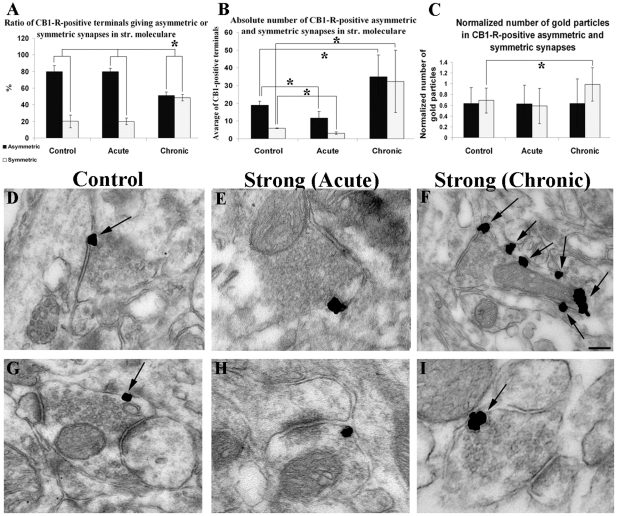
Quantitative changes of CB1-Rs in the acute and chronic phase of epilepsy.Graph A shows changes in the ratio of CB1-R immunopositive terminals establishing symmetric versus asymmetric synapses in control and epileptic tissue in str. moleculare of the DG. No difference was found in the hippocampi of strong animals in the acute phase compared to controls. However, in strong animals in the chronic phase a significant increase occurred in the ratio of stained symmetric versus asymmetric synapses. Graph B shows changes in the absolute number of symmetric versus asymmetric synapses in control and epileptic tissue. Significant decrease was found in the number of stained asymmetric and symmetric synapses in the hippocampi of strong animals in the acute phase, compared to controls. In contrast, in strong animals in the chronic phase, the number of immunostained asymmetric and symmetric synapses significantly increased. Graph C shows changes in the normalized number of gold particles in control and epileptic tissue. No difference appears in the mean quantity of gold particles in asymmetric synapses in control or in epileptic tissue (acute or chronic phase). No difference was seen in case of symmetric synapses between the hippocampi of control and acute epileptic mice either. However, in chronically epileptic tissue the number of gold particles located in symmetric terminals increased significantly. Statistics were calculated with Mann-Whitney test (p<0.05). High power electron micrographs of CB1-R immunolabelled axon terminals from the str. moleculare of the DG of controls (D,G) acute and chronic animals 2 hours (E, H) and 1month (F, I) post pilo. Our antibody labels both CB1-R-positive terminals giving symmetric (D, E, F) and asymmetric (G, H, I) synapses. Gold particles are located extrasynaptically. In the chronic, strong tissue the number of gold particles on terminals forming symmetric synapses has increased (F). Scale: 200 nm.